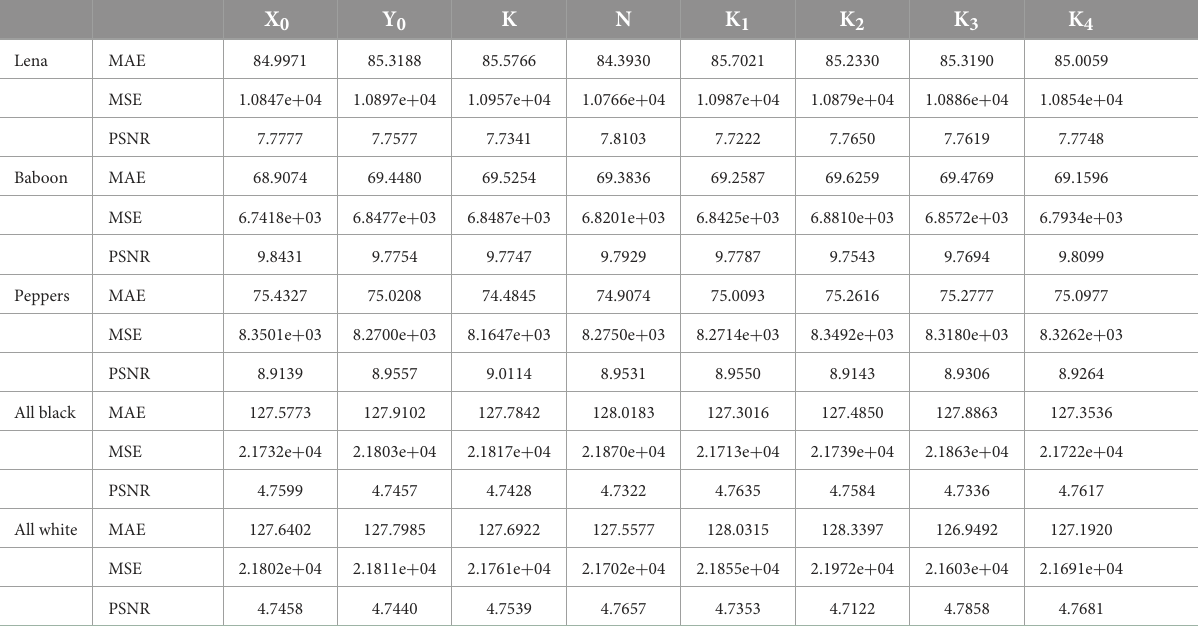
TABLE 15 Key sensitivity analysis results at the decryption